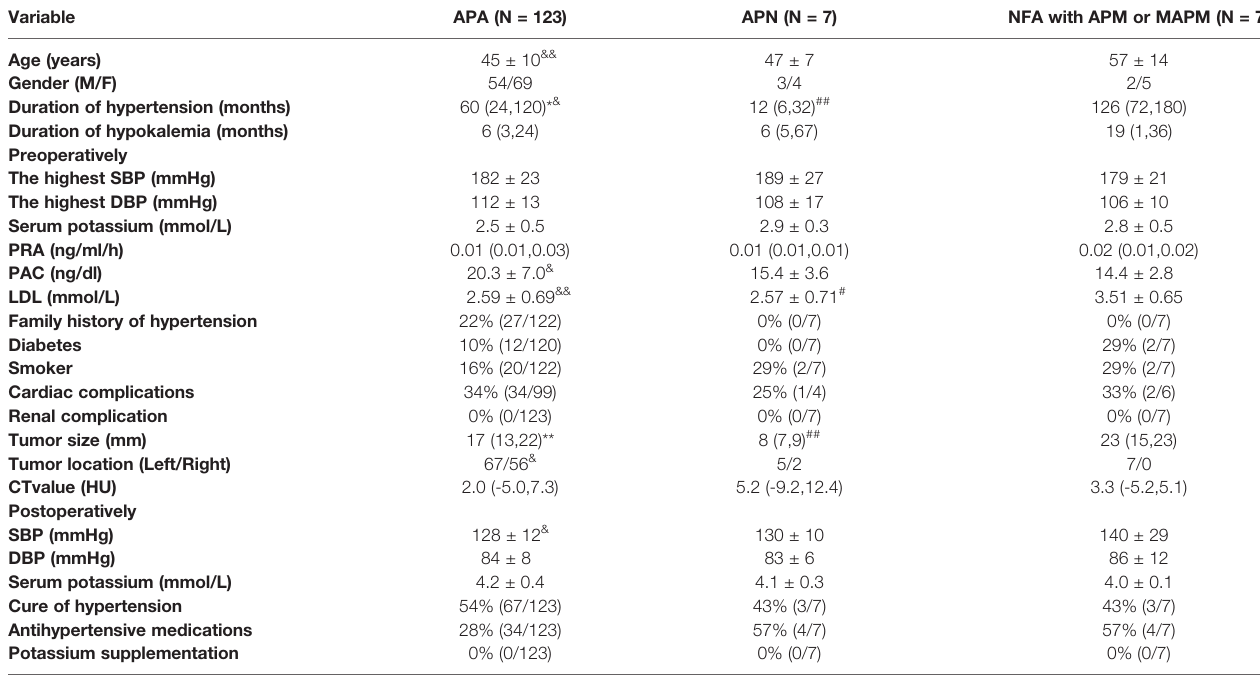
TABLE 1 | Clinical characteristics of patients with aldosterone-producing adenoma, aldosterone-producing nodule and non-functioning